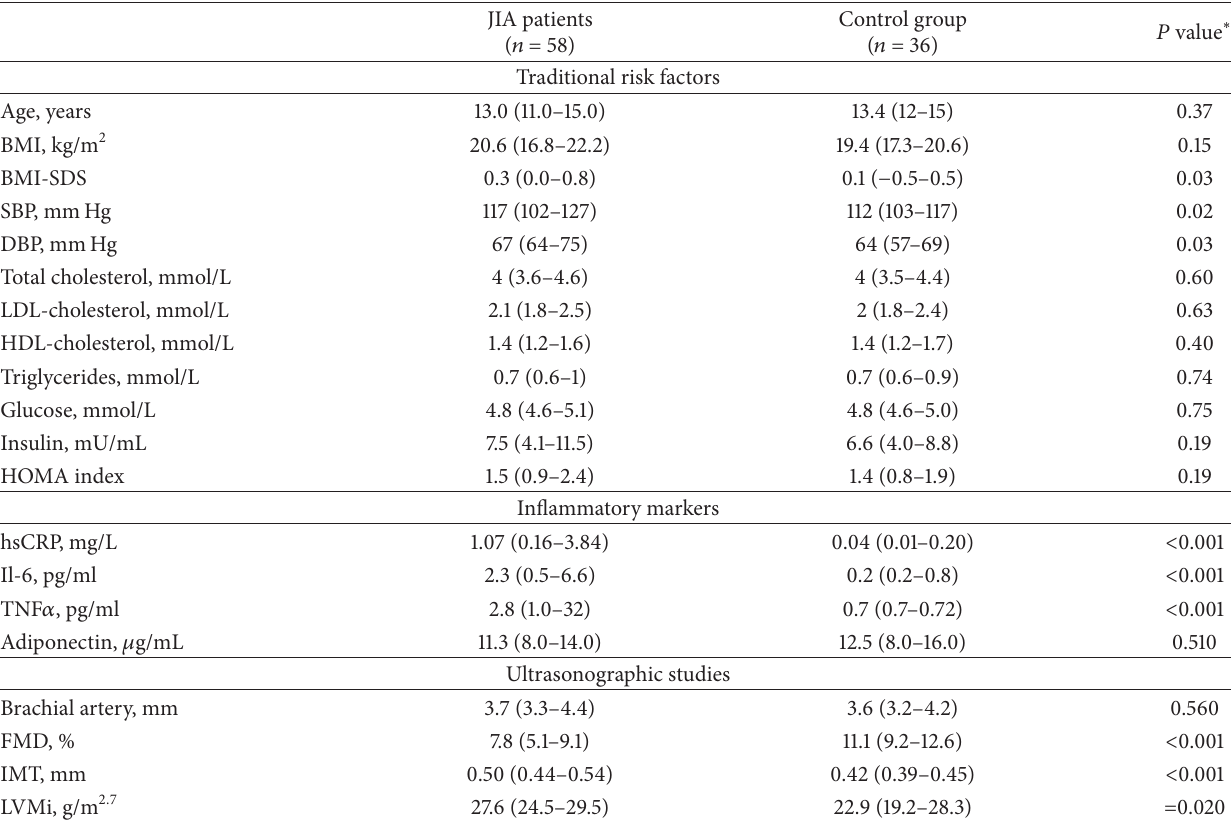
Table 2: Traditional cardiovascular risk factors, selected inflammatory markers, and ultrasonographic evaluation of cardiovascular system in the juvenile idiopathic arthritis (JIA) patients and the control